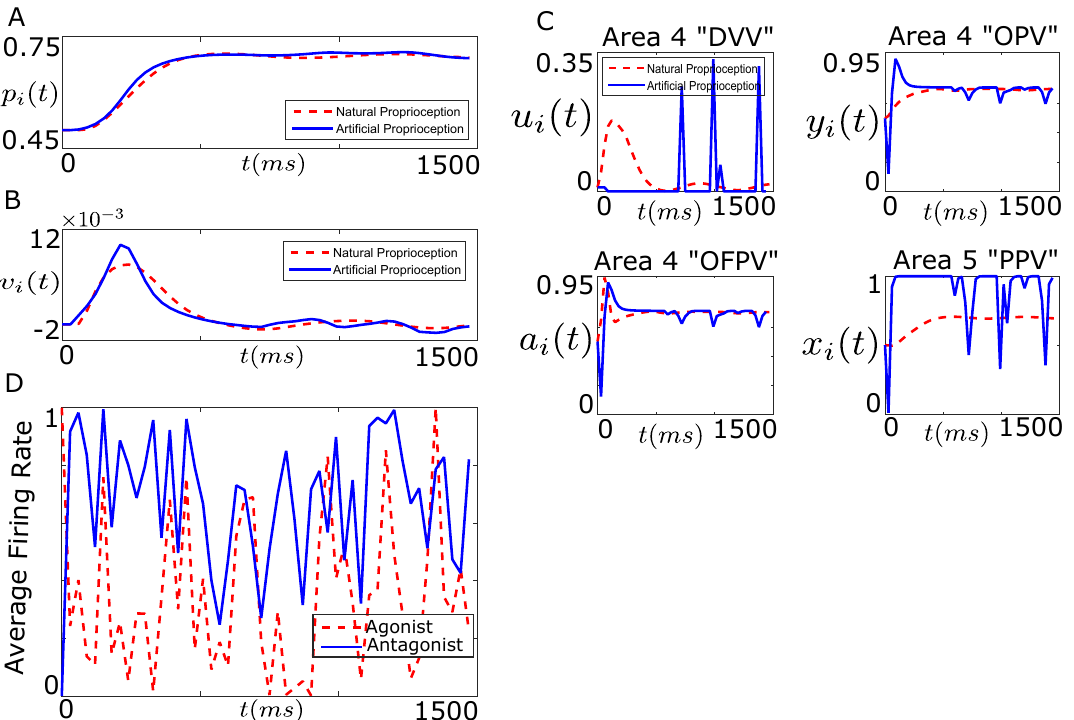
Figure 14. Performance of the designed closed-loop BMI in tracking the desired position trajectory (Figure 12). ( A ) shows the position trajectory of the agonist muscle i in the presence of the designed artificial sensory feedback (solid line, blue) and the natural sensory feedback (dotted line, red); ( B ) shows the velocity trajectory of the agonist muscle i in the presence of the designed artificial sensory feedback (solid line, blue) and the natural sensory feedback (dotted line, red); ( C ) shows the average firing activity of a population of the cortical area 4 “DVV” neurons ( u i ( t ) ), “OPV” neurons ( y i ( t ) ), “OFPV” neurons ( a i ( t ) ), and the cortical area 5 “PPV” neurons ( x i ( t ) ) in the presence of the artificial sensory feedback (solid line, blue) and the natural sensory feedback (dotted line, red); ( D ) Firing trajectory of the agonist and the antagonist population of the spiking